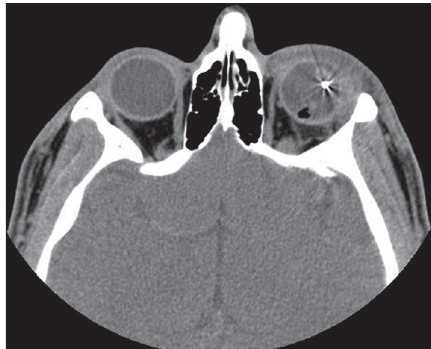
Figure 4: Open globe injury in a 34-year-old man. Axial unen- hanced CT image showing a metallic intraocular foreign body.